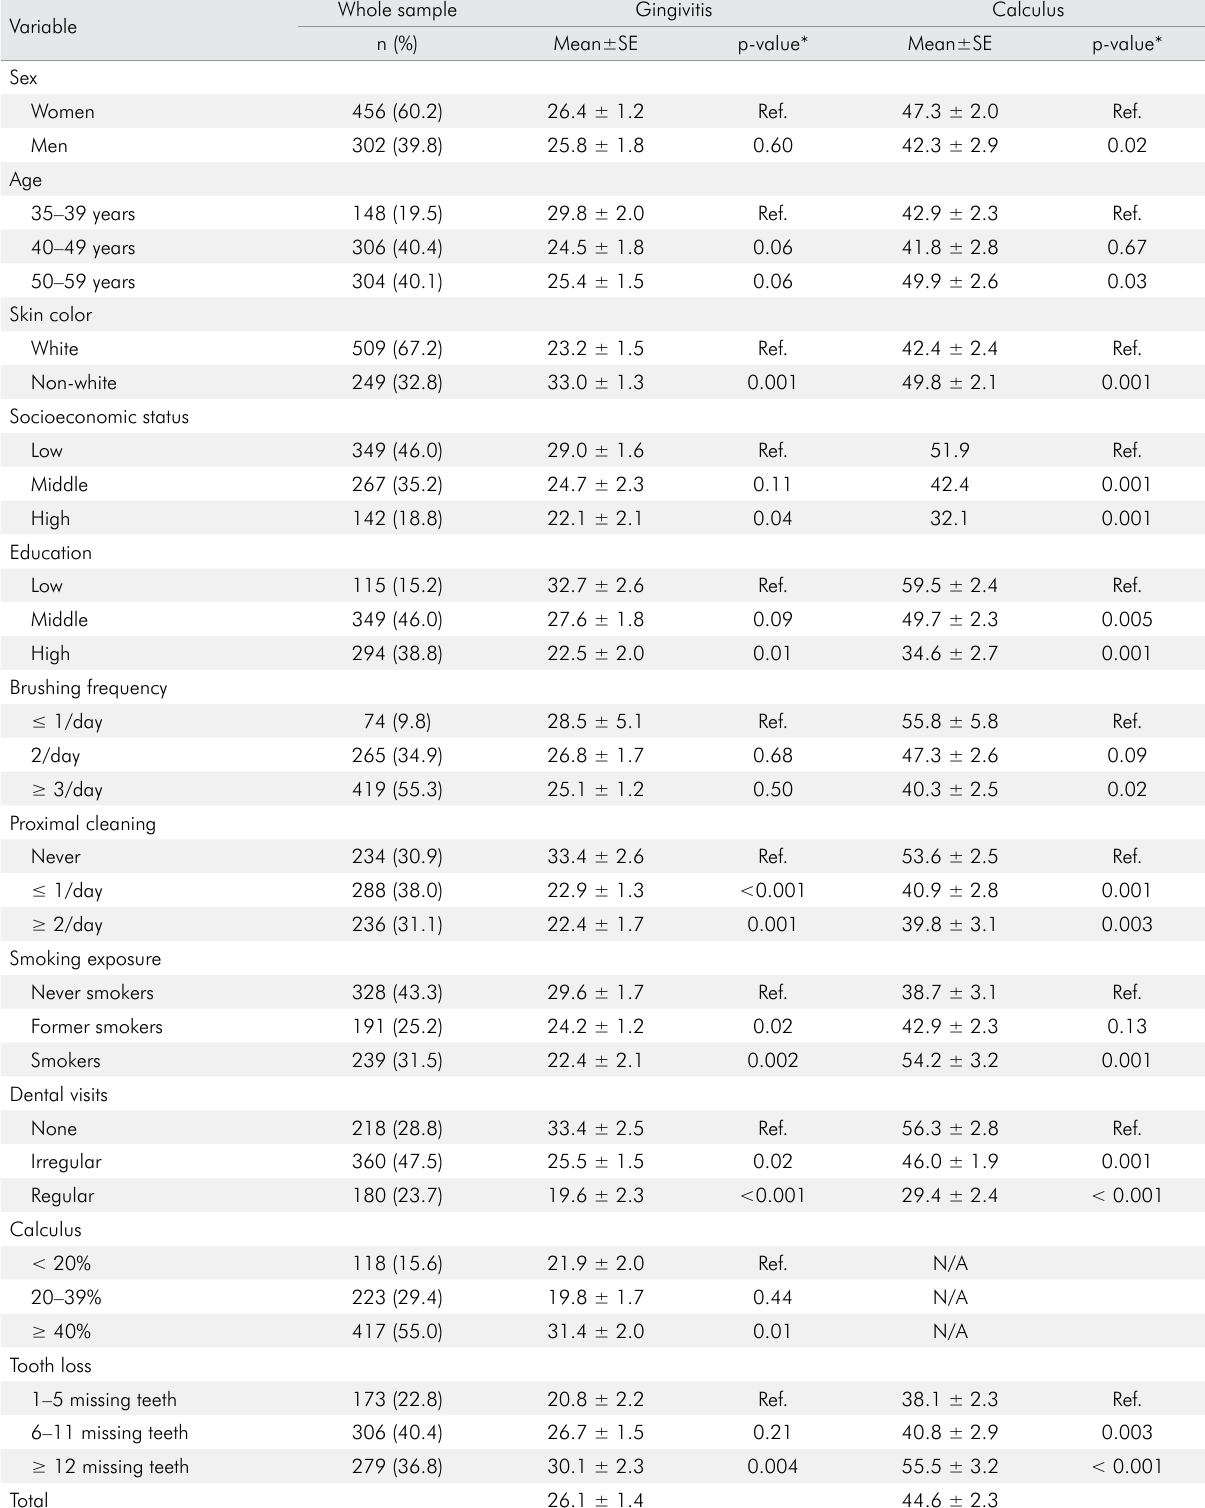
Table 1. Mean percentage of sites per subject with gingival bleeding and calculus according to demographic, behavioral and clinical